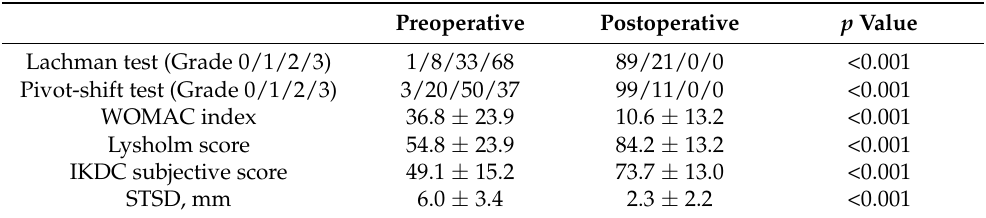
Table 2. Comparison of preoperative and postoperative outcomes in all